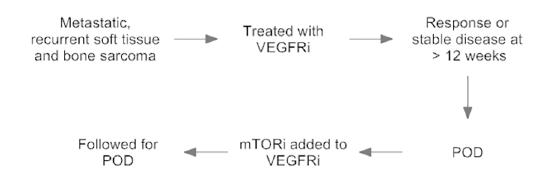
Fig 1. Patient flow chart on VEGFRi & VEGFRi + mTORi. VEGFRi = vascular endothelial growth factor receptor inhibitor; POD = progression of disease; mTORi = mammalian target of rapamycin